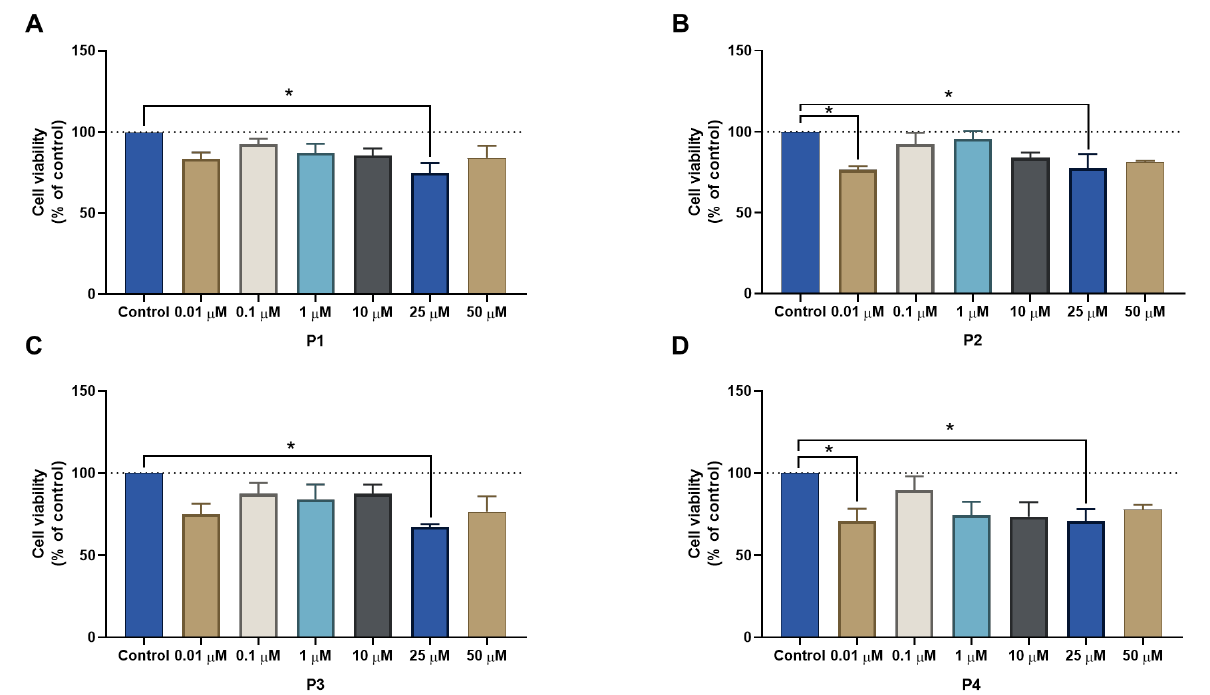
Figure 13. Cytotoxic results of PC-3 after exposure to increasing concentrations of peptides ( A ) P1, ( B ) P2, ( C ) P3, and ( D ) P4 (0.01–50 µ M) for 48 h. Control cells were treated with 0.01% DMSO (vehicle). Cell viability was obtained using the MTT assay, and the results are given as the mean ± SEM ( n = 3). * Statistically significant vs. control (vehicle) at p < 0.05.